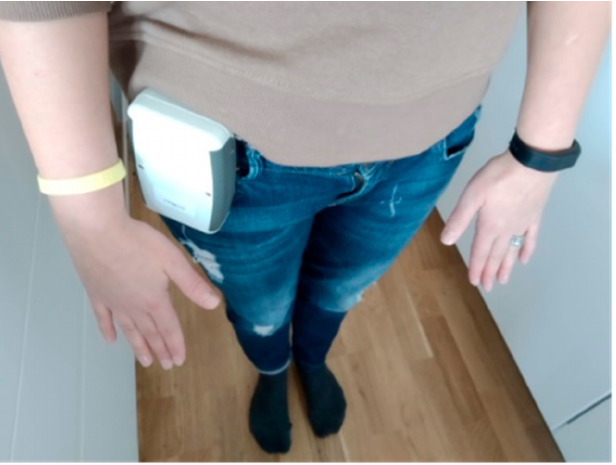
Figure 1. PPM device (white box attached to clothes) worn by a